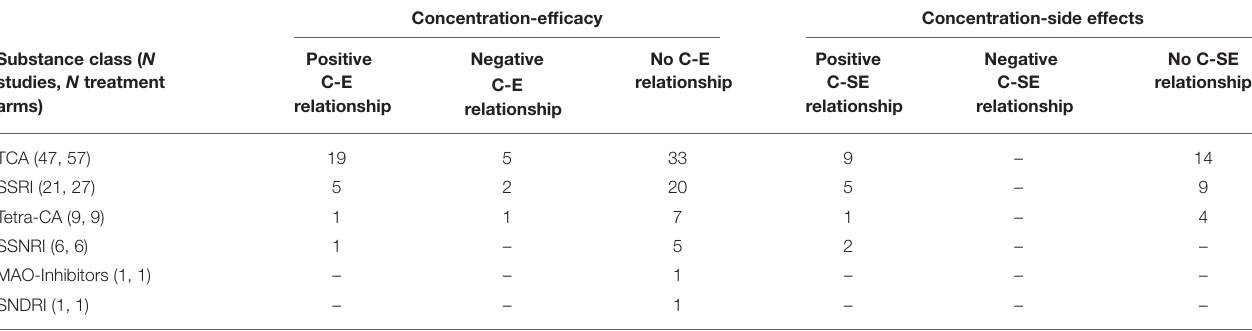
TABLE 3 | Summarized results of the qualitative synthesis of 101 treatment arms in 65